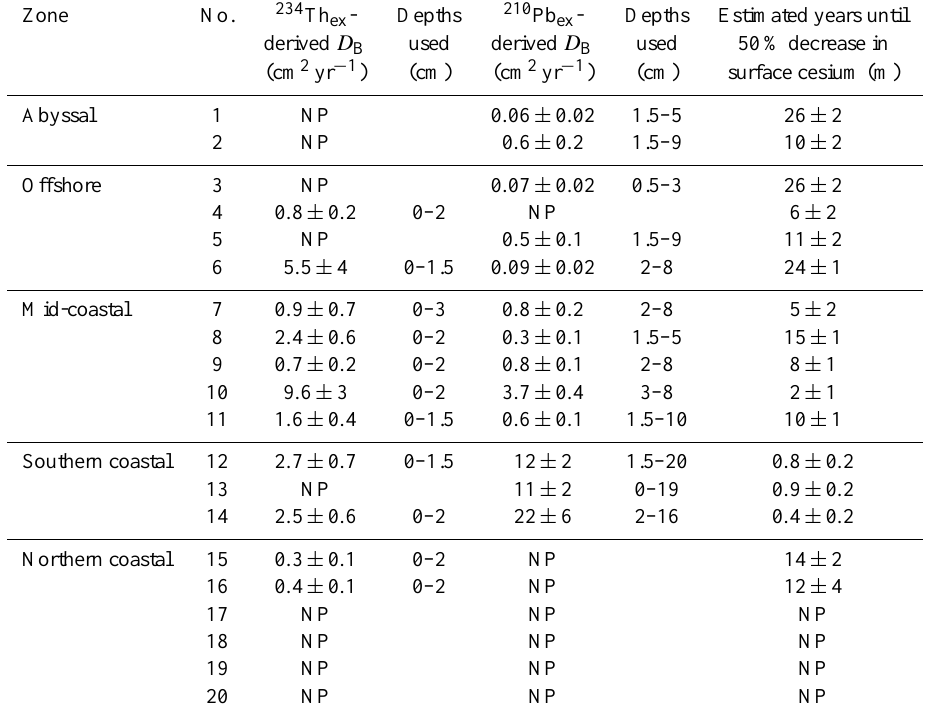
Table 2. Mixing rates and model results for sediment cores. Analysis of samples from cores marked NP was not possible because no 234 Th ex was present or because of insufficient trends in 234 Th ex or 210 Pb ex . Due to the limited number of surface 234 Th ex points, the uncertainties reported represent the higher of the standard uncertainty of the model fit for variable D B or 25% of D B . The last column contains values representing the time in years since the Fukushima maximum for surface concentrations (0–3cm) to decrease by 50% via mixing (modeled). The uncertainties reflect the mixing rate(s) used in the